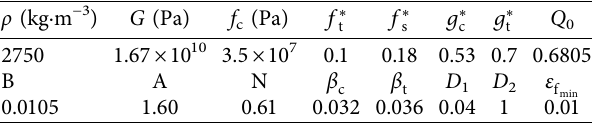
Table 1: Parameters of rock material.